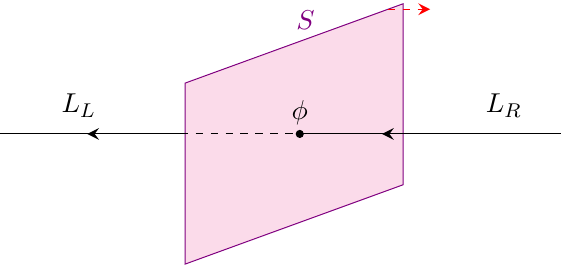
Figure 2 . Piercing a defect S by a line operator L . At the junction, there is a monopole operator φ as required by gauge